Question: State the chart type depicted above.
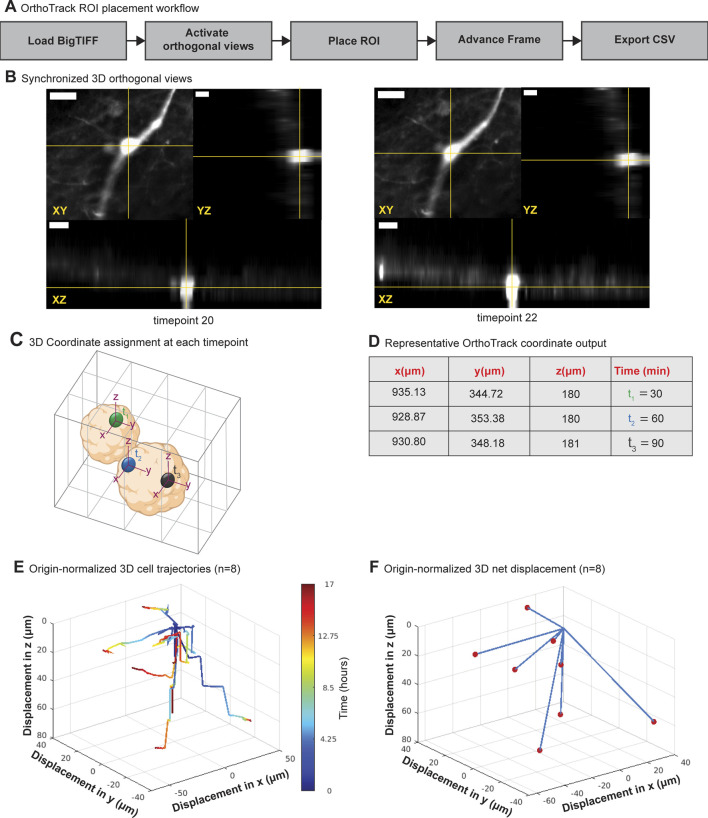
Answer: bar